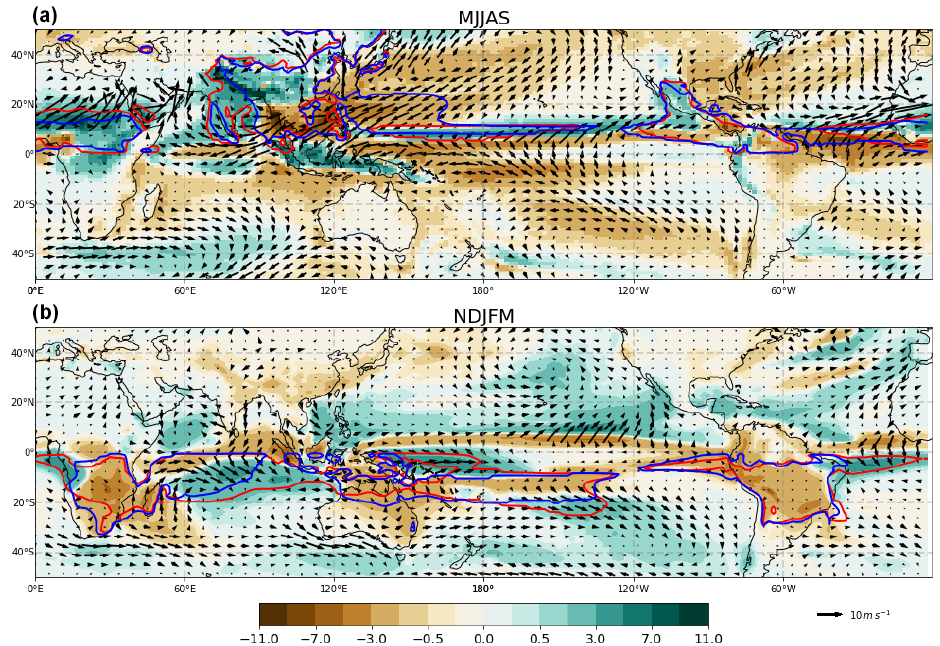
Figure 6. Precipitation anomaly (mmd − 1 ) with surface wind anomaly overlaid. (a) MJJAS; (b) NDJFM. Monsoon domains, defined as regions in which the precipitation during the monsoon season (NH: MJJAS; SH: NDJFM) is greater than the dry season (NH: NDJFM; SH: MJJAS) by at least 2.5mmd − 1 and responsible for at least 55% of the annual precipitation, are shown for the LIG (red contours) and for PI (blue contours) periods.